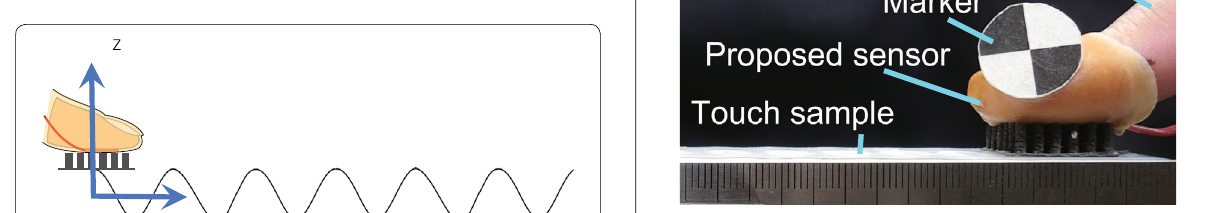
Fig. 4 Photograph of a finger wearing our proposed sensor during tracing. The marker attached to the tactile sensor is used for camera position